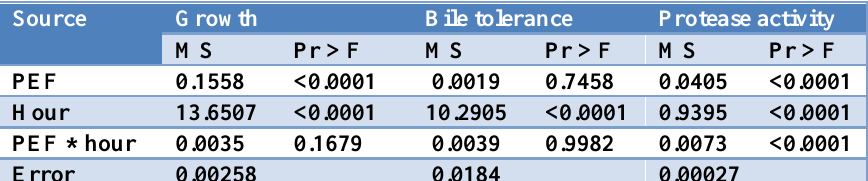
Table, 4: Least square means for growth, bile tolerance and protease activity of Lactobacillus acidophilus LA-K as influenced by mild pulsed electric field. Treatment Growth Bile Protease activity tolerance LSMean